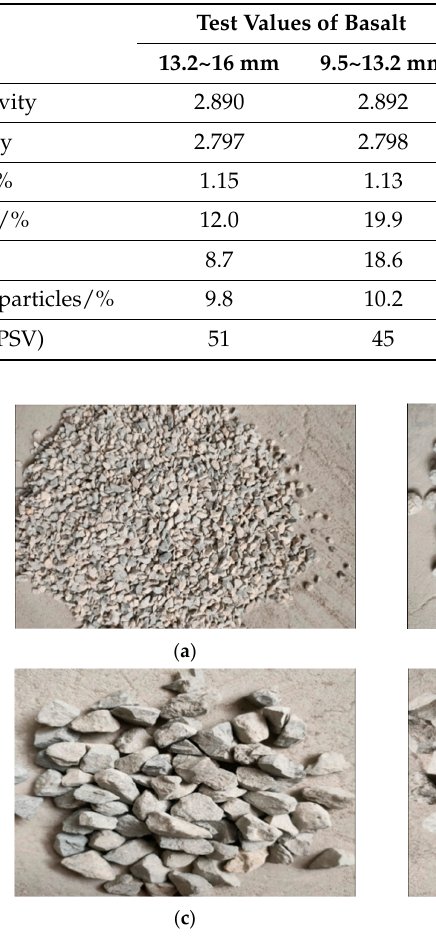
Figure 1. Two kinds of lithological coarse aggregates. ( a ) 2.36–4.75 mm limestone, ( b ) 4.75–9.5 mm limestone, ( c ) 9.5–13.2 mm basalt, and ( d ) 13.2–16 mm basalt.